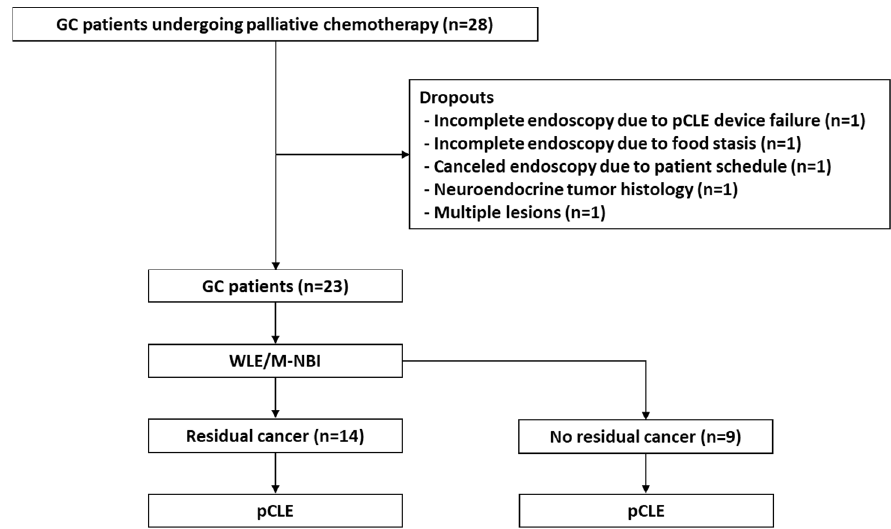
Figure 1. Brief illustration of the study protocol and patient grouping. GC, gastric cancer; M-NBI, magnified narrow-band imaging; pCLE, probe-based confocal laser endomicroscopy; WLE, white- light endoscopy.